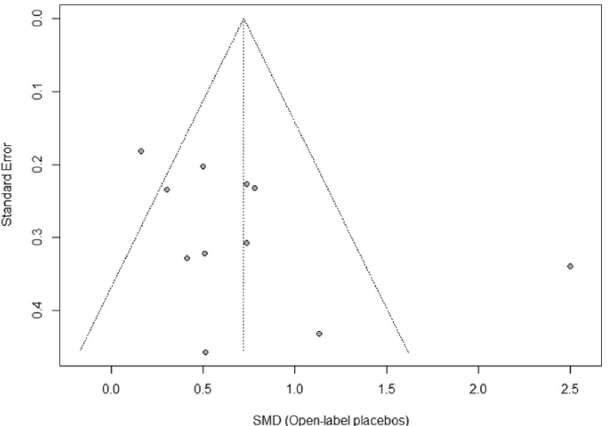
Figure 3. Funnel plot of standardized between-group OLP vs. NT scores. Funnel plot of standardized mean difference (SMD) vs. standard error. The dotted lines indicate the triangular region within which 95% of studies are expected to lie in the absence of publication bias.